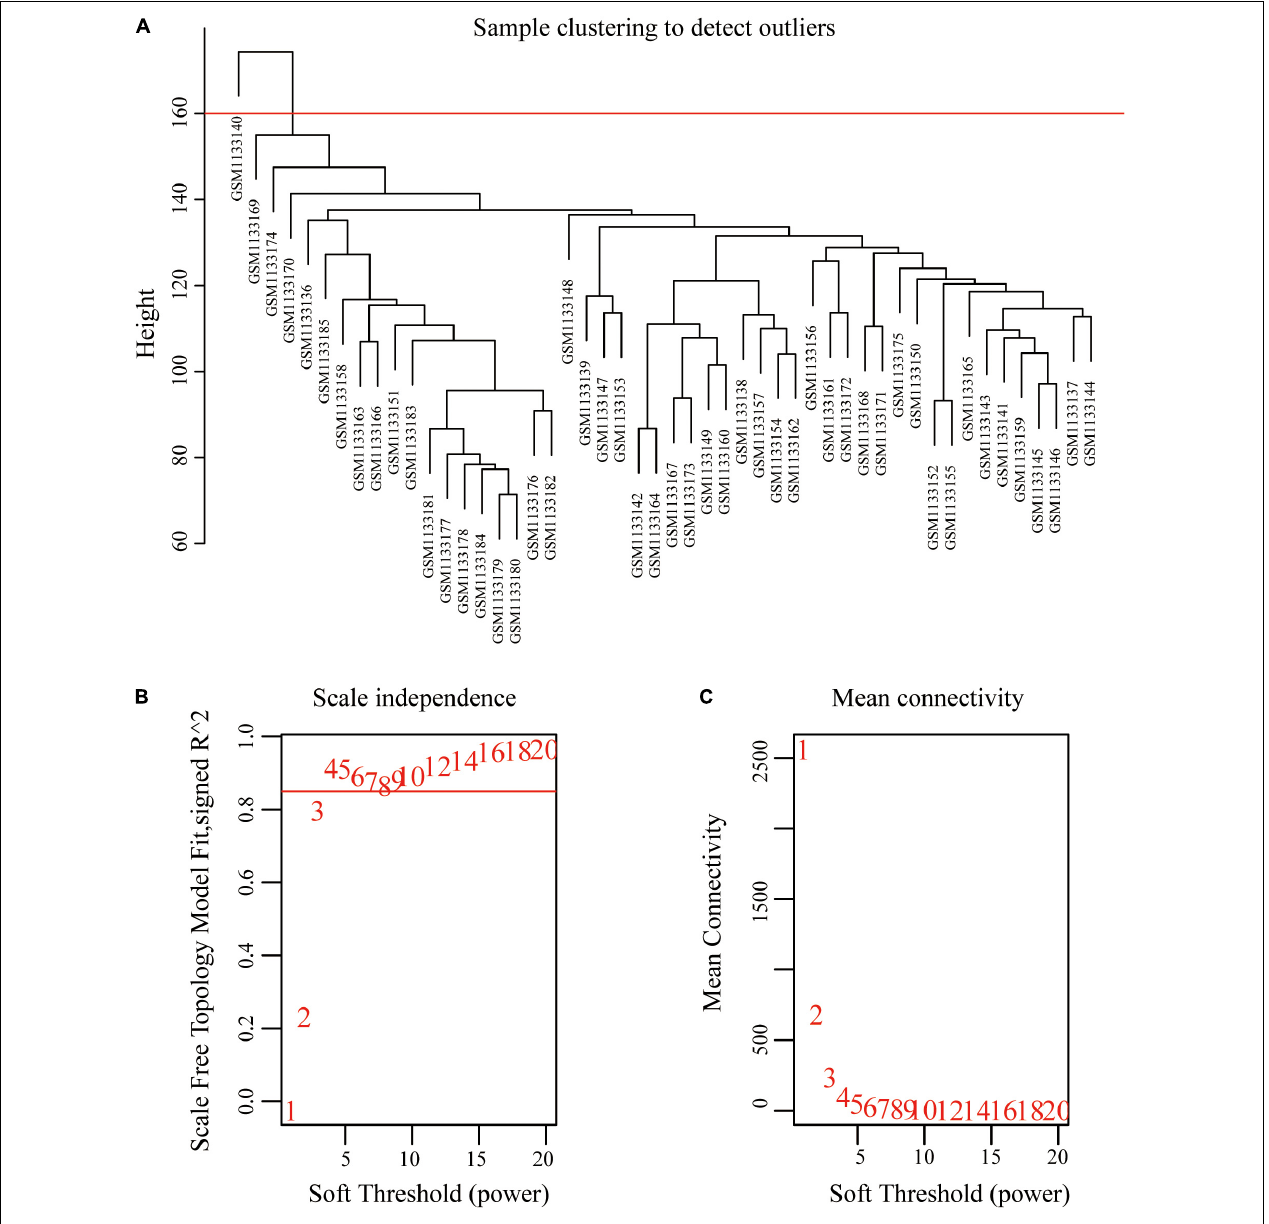
FIGURE 1 | Sample clustering to detect outliers and determine soft-threshold power. (A) Clustering based on expression data of GSE46602, with 160 as the threshold, one outlier was removed. (B) Analysis of the scale-free fit index for various soft-threshold powers. (C) Analysis of the mean connectivity for various soft-threshold